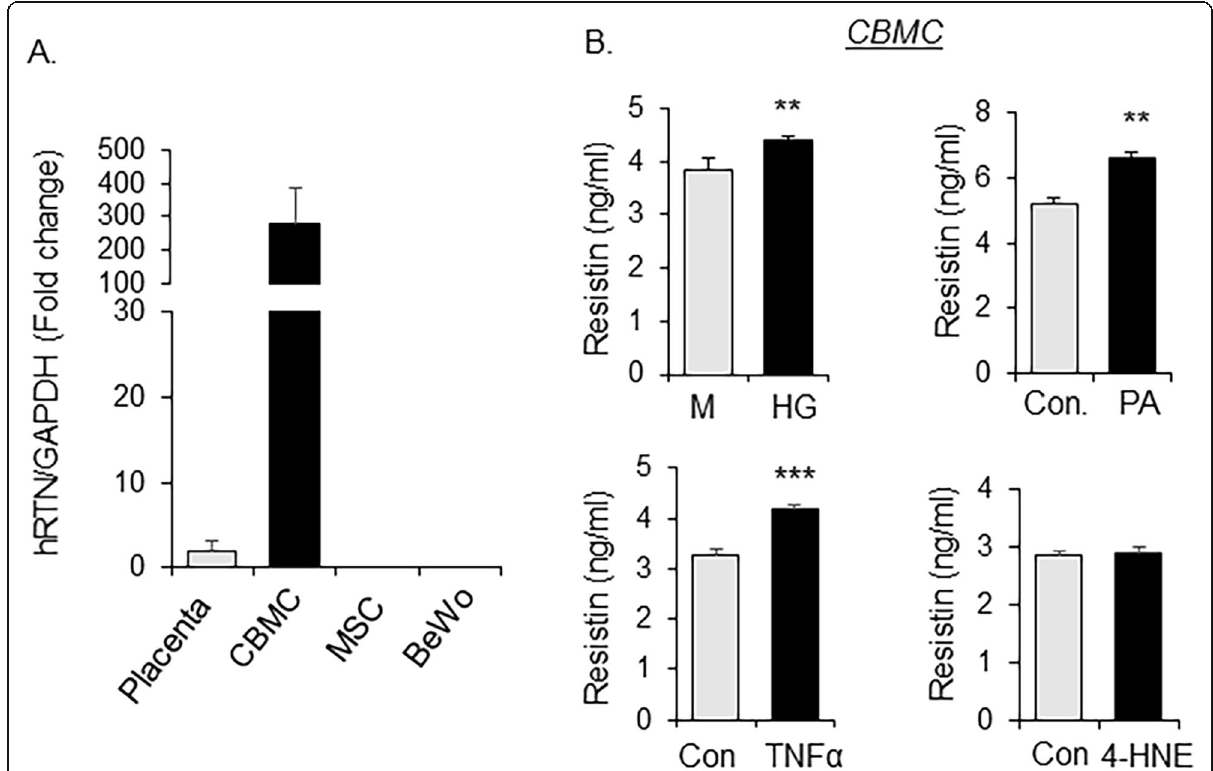
Fig. 3 Secretion of resistin from cord blood mononuclear cells in response to metabolic stresses. a Expression of resistin mRNA in placenta and cord blood mononuclear cells (CBMCs), cord tissue mesenchymal stem cells (MSC) of healthy subjects ( N = 5 subjects for placental tissues and CBMCs; N = 3 subjects for MSCs), and BeWo cells (trophoblast cell line) were measured by quantitative RT-PCR; b Mononuclear cells were isolated from cord blood of healthy pregnant women and were treated with TNF α (100 ng/ml), high glucose (25 mM), palmitate acid (0.6 mM), or 4- Hydroxynonenal (4-HNE, 0.6 mM) for 16 h, followed by measuring resistin levels in culture media with ELISA. M: mannitol treated group as an osmotic control for high group treatment. Mean ± SD, ** P < 0.01; *** P < 0.001; N =